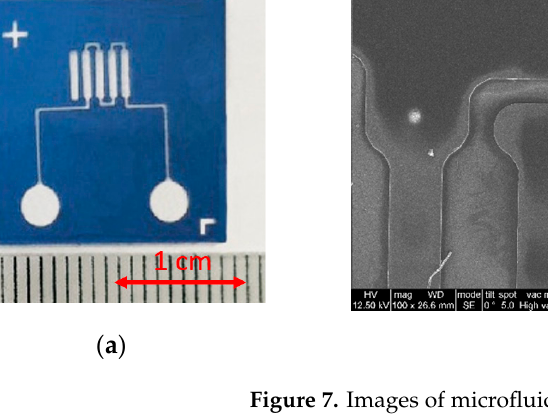
Figure 7. Images of microfluidic system formed using Ordyl Alpha 350 dry film photoresist: ( a )—general view of the microfluidic system, ( b )—SEM-image of the detection zone section, ( c )—SEM-image of the microfluidic channel.